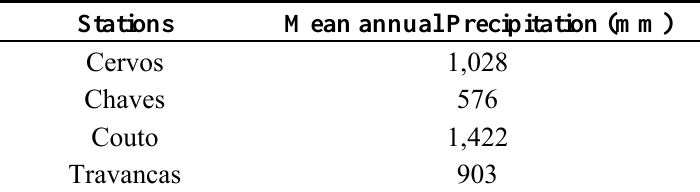
Table 2. Mean annual precipitation for values measured in the monitoring stations depicted in Figure 3. Data for the hydrological year 1985 to 2008.